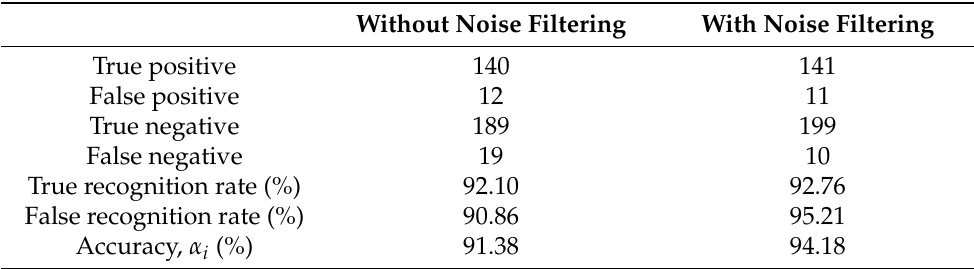
Figure 11. Accuracies of training and validation of the CNN model for classifying noise-filtered speech and other sounds ( a ) as well as the corresponding loss changes ( b ) (1.0 is 100% accuracy in this graph). Table 3. Accuracy of the CNN model for cattle vocalization classification without noise filtering.